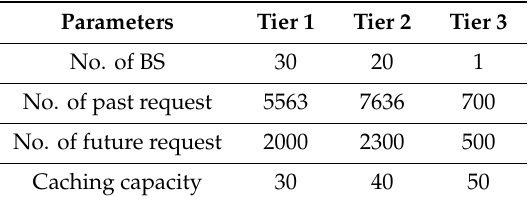
Table 2. List of